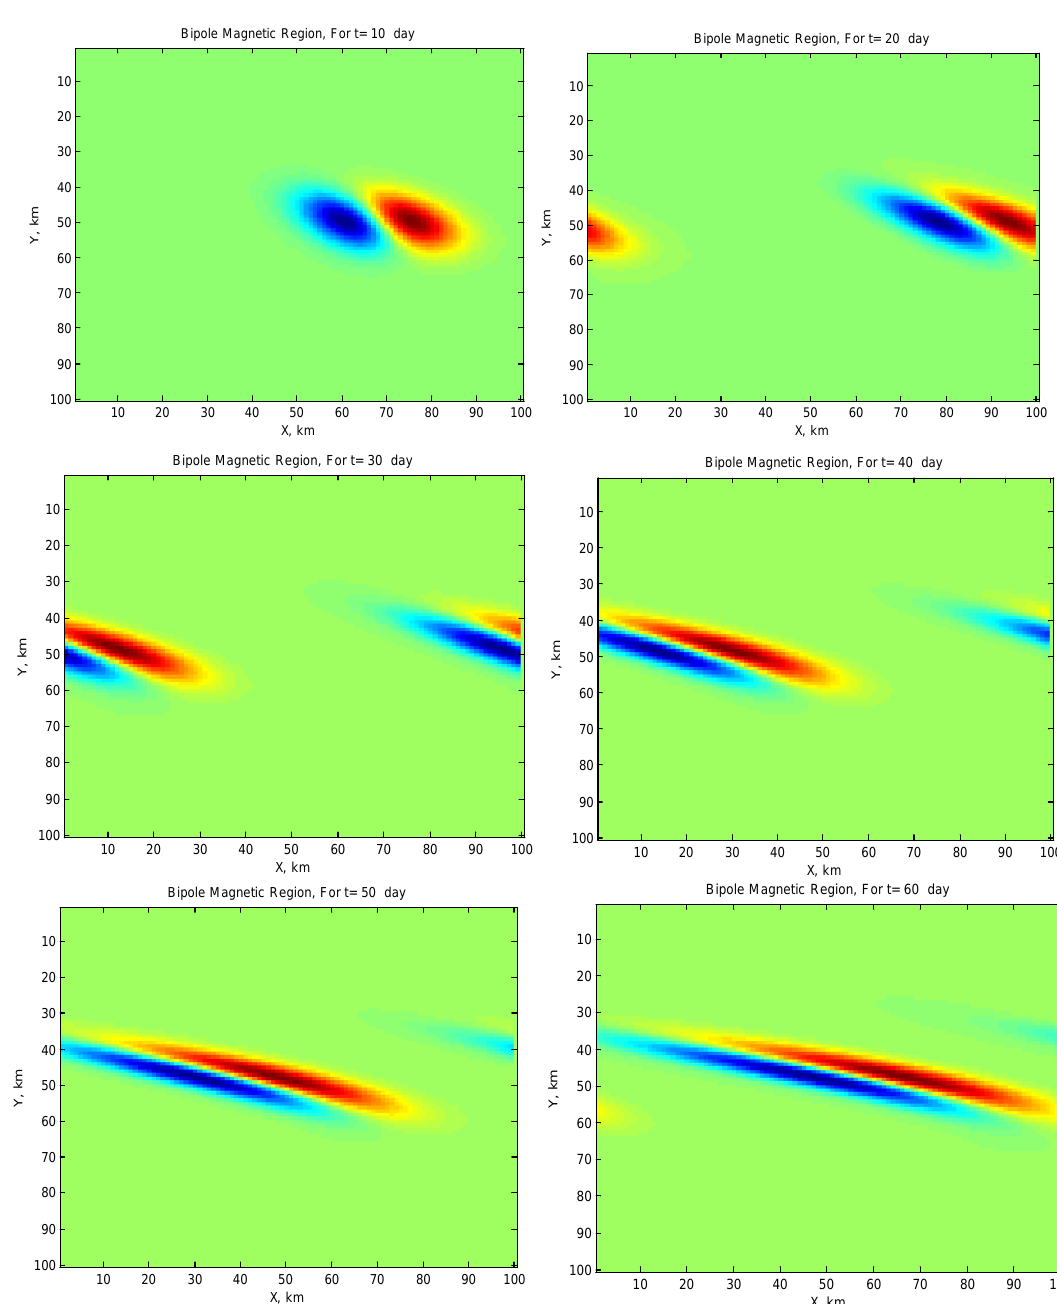
Fig. 5: Explicit numerical solution of equation of magnetic transport flux for 60 days and